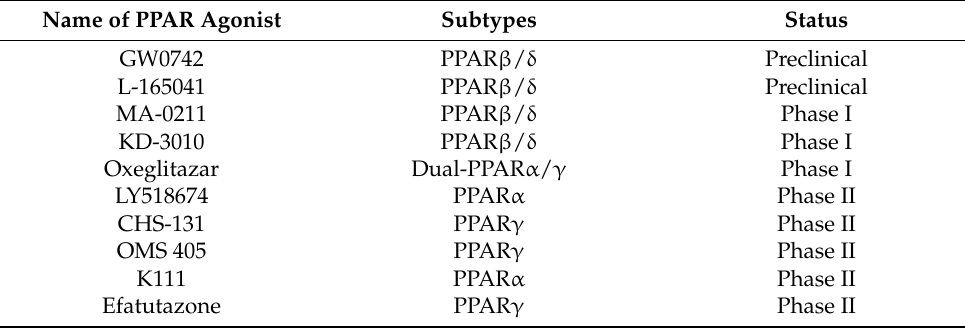
Table 1. PPARs agonists and their current status in clinical